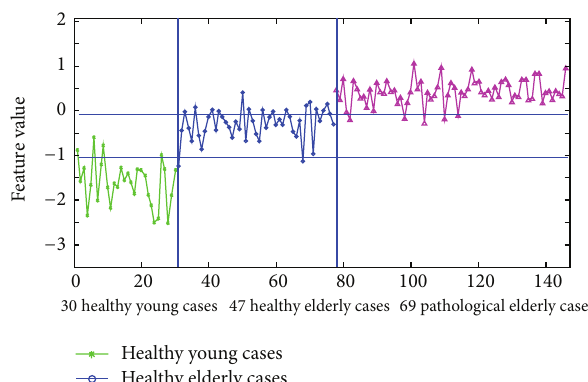
Figure 18: Differentiation between healthy young, healthy elderly, and pathological elderly cases (suffering from CAD), when using the normalizedsumoftheareasunderthecorrespondingstandarddeviationcurve’senvelopeforeachcase,asaclassificationfeatureorparameter.